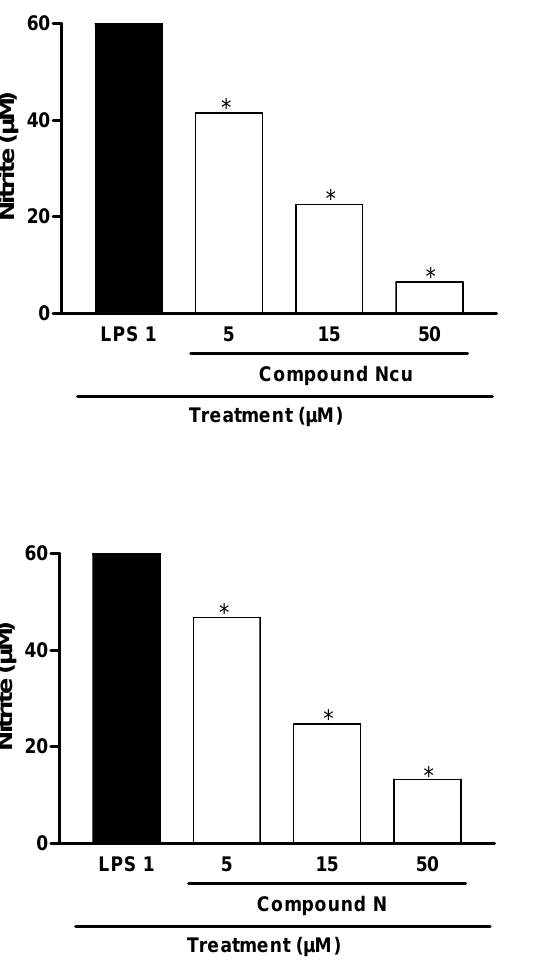
Figure 5. Effect of treatment with Complex 1 (NCu) or Naringin (N) (5, 15 or 50 μ M) on nitrite production by RAW 264.7 cells stimulated with 1 µg/mL LPS for 20 h or on cell viability on MTT assay. Bars represents the mean ± S.E.M. of three independent experiments performed in triplicate and asterisks indicate significant inhibition of enzyme activity in relation to the untreated group, P <